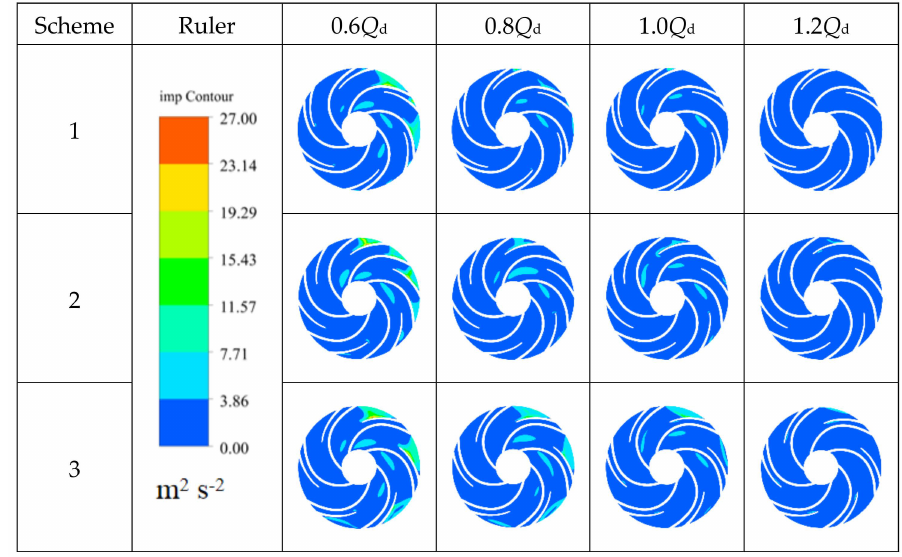
Figure 8. Turbulent kinetic energy distribution cloud map in a cross-section of the impeller under di ff erent flow rates in pure water